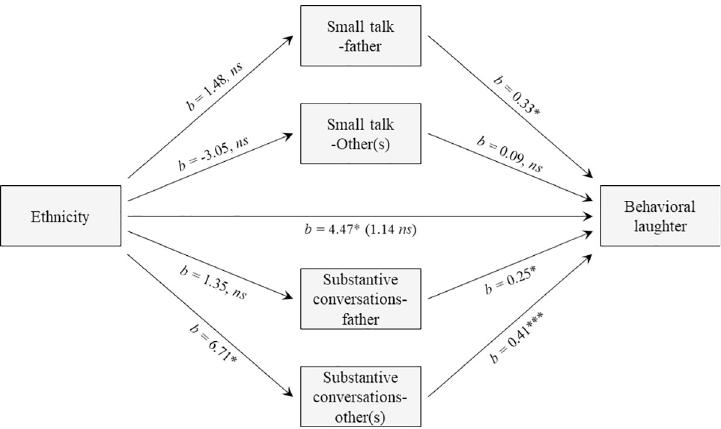
Fig 4. Mediation analyses. This analyses shows that substantive conversations-other(s) mediates the relationship between ethnicity and laughter. b = indicates the regression coefficient. � p < .05, �� p < .01, ��� p <